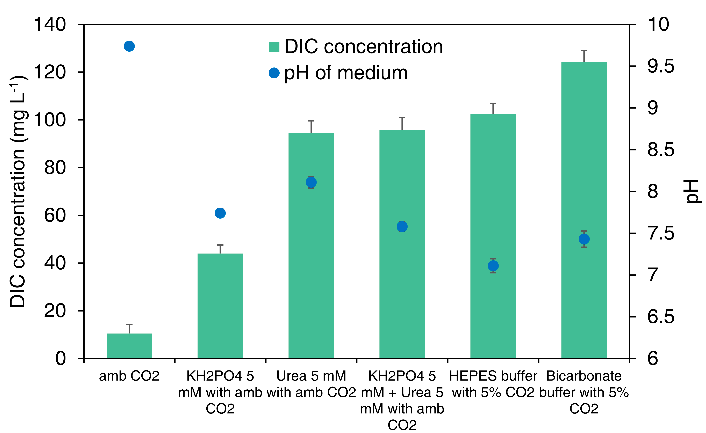
Figure 4. Comparison of dissolved inorganic carbon (DIC) concentration and pH of the medium with different CO 2 concentrations (ambient CO 2 and 5% CO 2 ), chemical fertilizers (urea and KH 2 PO 4 ), and buffer systems (HEPES buffer and bicarbonate buffer) after 4 days of microalgae cultivation. Results represent the mean ± standard deviation (SD) of three replicates.